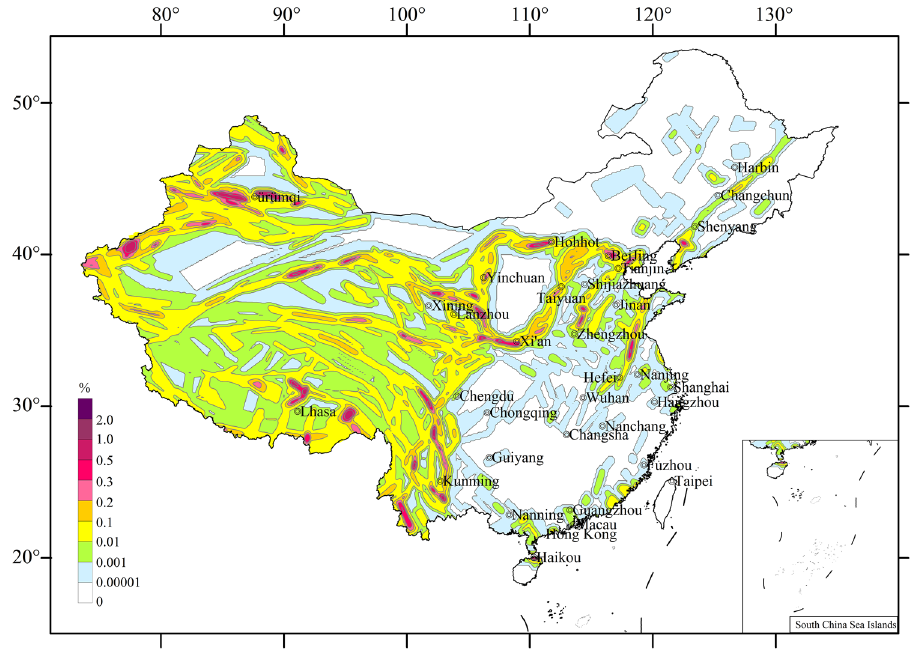
Fig. 13 Spatial distribution of the probability of the modi- fied Mercalli intensity (MMI) greater than or equal to X earth- quakes for China’s mainland